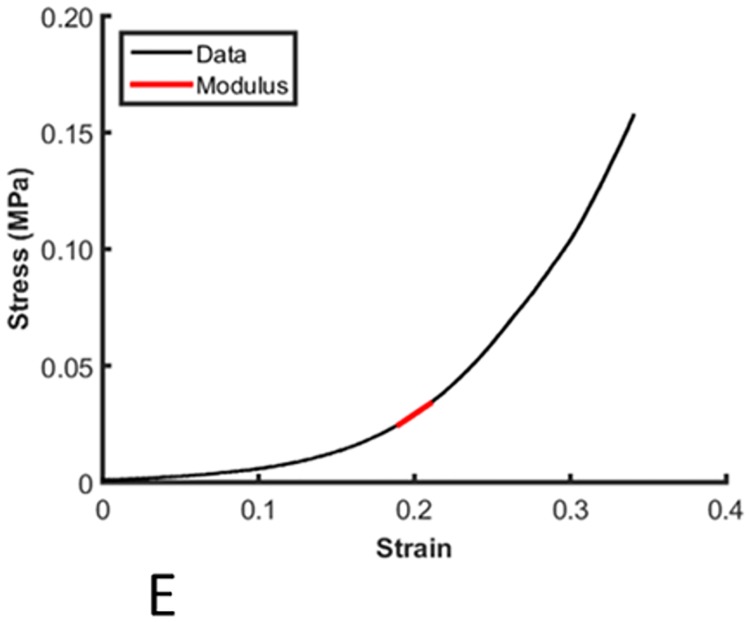
Modulus measurement on the stress-strain curve.A typical stress strain curve from a compression test at 20% strain, with the modulus measurement point indicated by the red line.